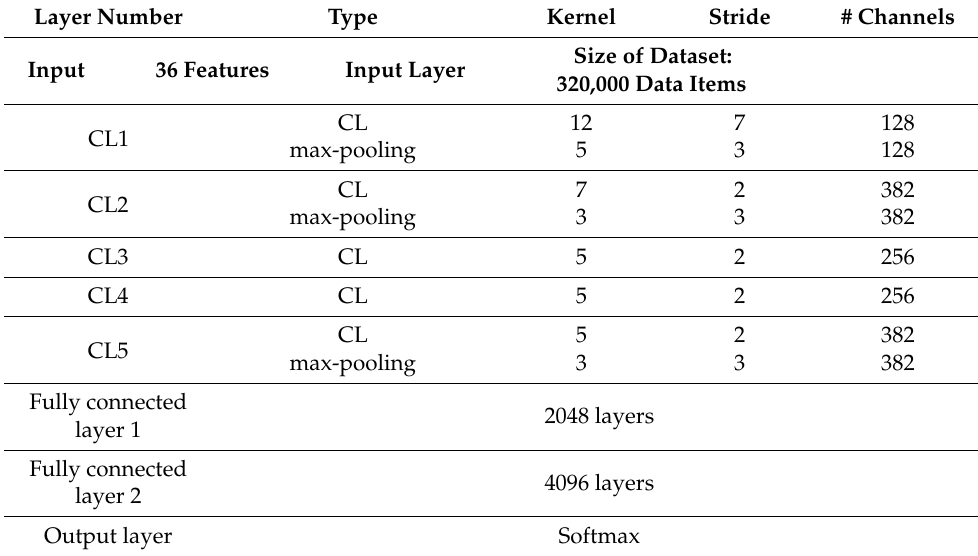
Table 3. The transfer learning proposed CNN configuration.